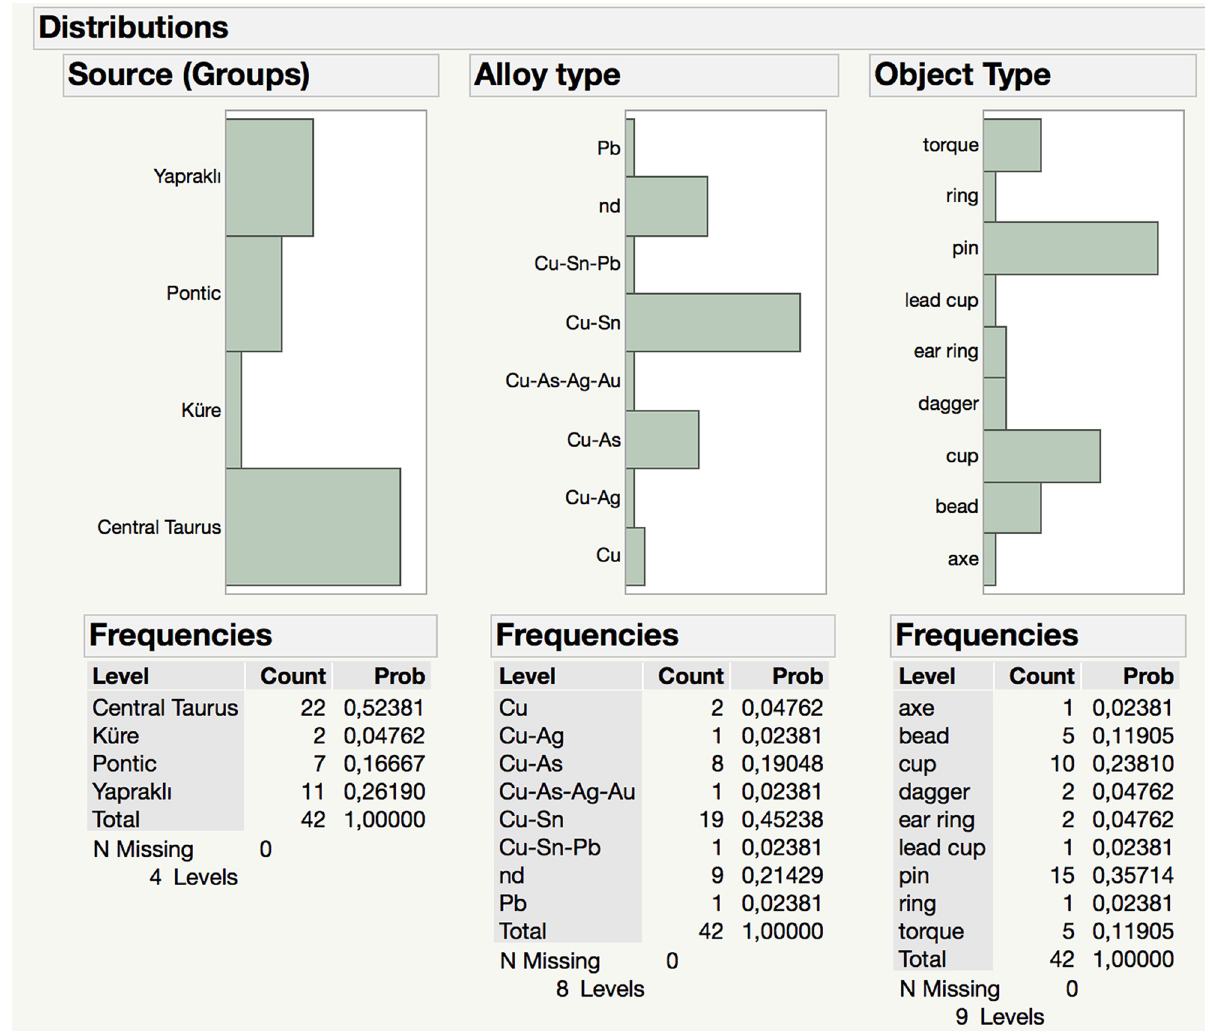
Fig 14. Numerical distribution graphs of alloy types and object types among suggested provenance (source groups) of metal objects.